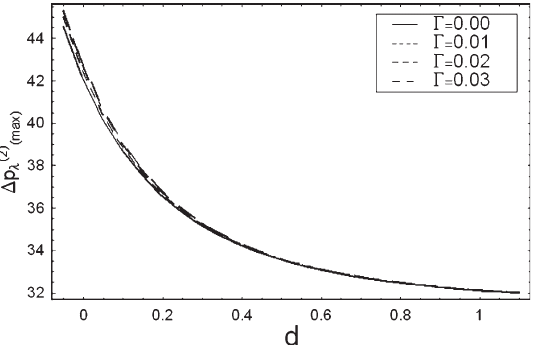
with Fig. 11. Effect of phase difference φ on variation of (cid:16)p (2) λ (max) Re for a = 0 . 5, b = 0 . 7, d = 1 . 5, θ = 0 . 0001, (cid:15) = 0 . 02, β = 0 . 1, sin α = 0 . 2 and Fr =